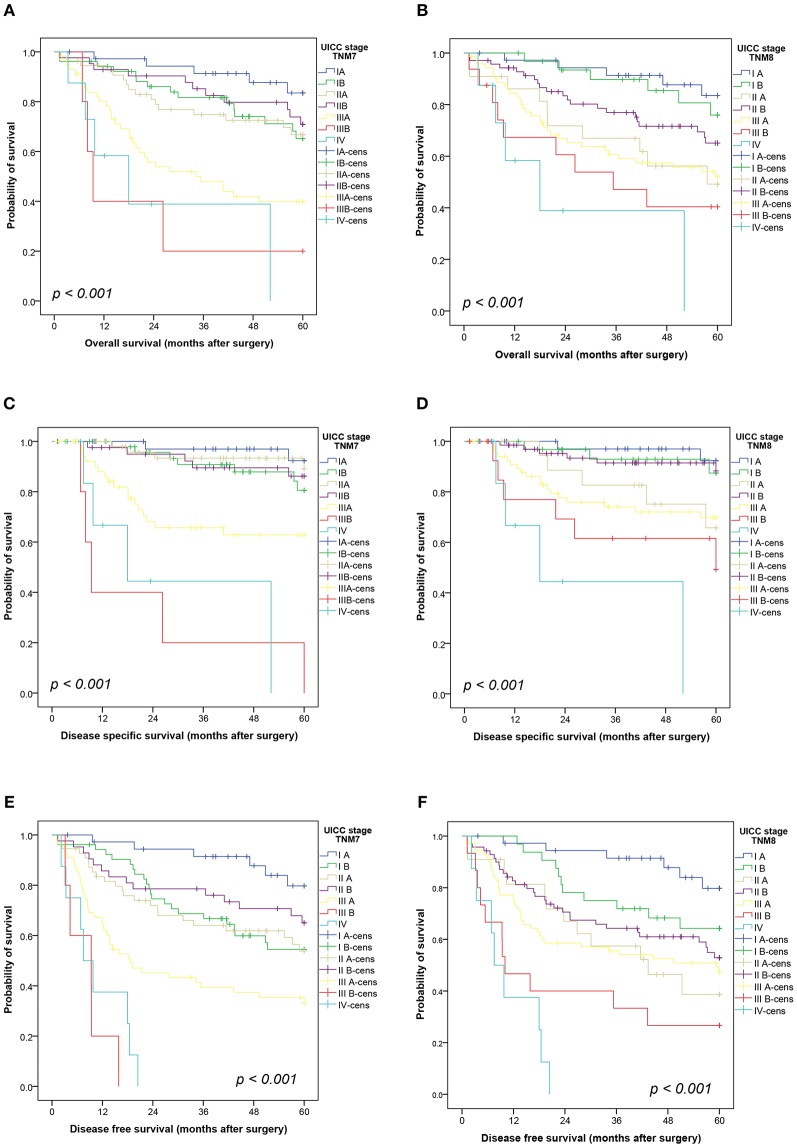
Kaplan-Meier curves showing the overall survival (A,B), disease-specific survival (C,D) and disease-free survival (E,F) by stage according to the seventh and eighth editions of the TNM classification. Comparisons were conducted using a log-rank test. cens, censored.